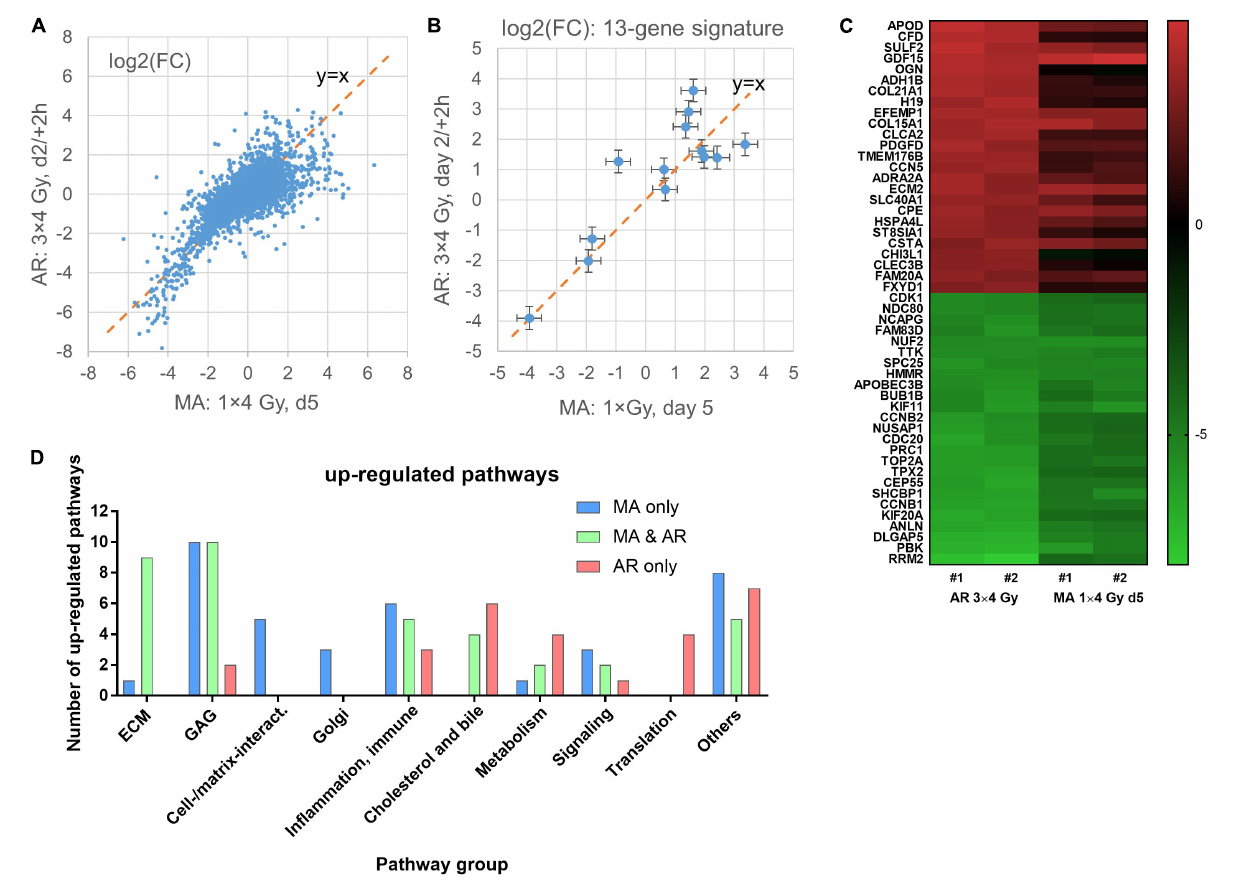
FIGURE 4 | Correlation of mean log2 fold changes [log2(FC)] after irradiation of confluent cultures with 3 × 4 Gy (AR protocol) and irradiation of exponentially growing cultures with 1 × 4 Gy (MA protocol) in microarray experiments #1–2 (A) . Same for the 13 genes in the predictive signature for subcutaneous fibrosis (Alsner et al., 2007). Mean values and 95% confidence intervals for data from experiments #1–2 are shown (B) . Heat map of the top25 up- and down-regulated genes for irradiation with the AR protocol and the same genes on day 5 for the MA protocol; data from independent replicate experiments #1–2 (C) . Number of pathways by functional group for pathways that were significant for only one of the two or common to both protocols (D)